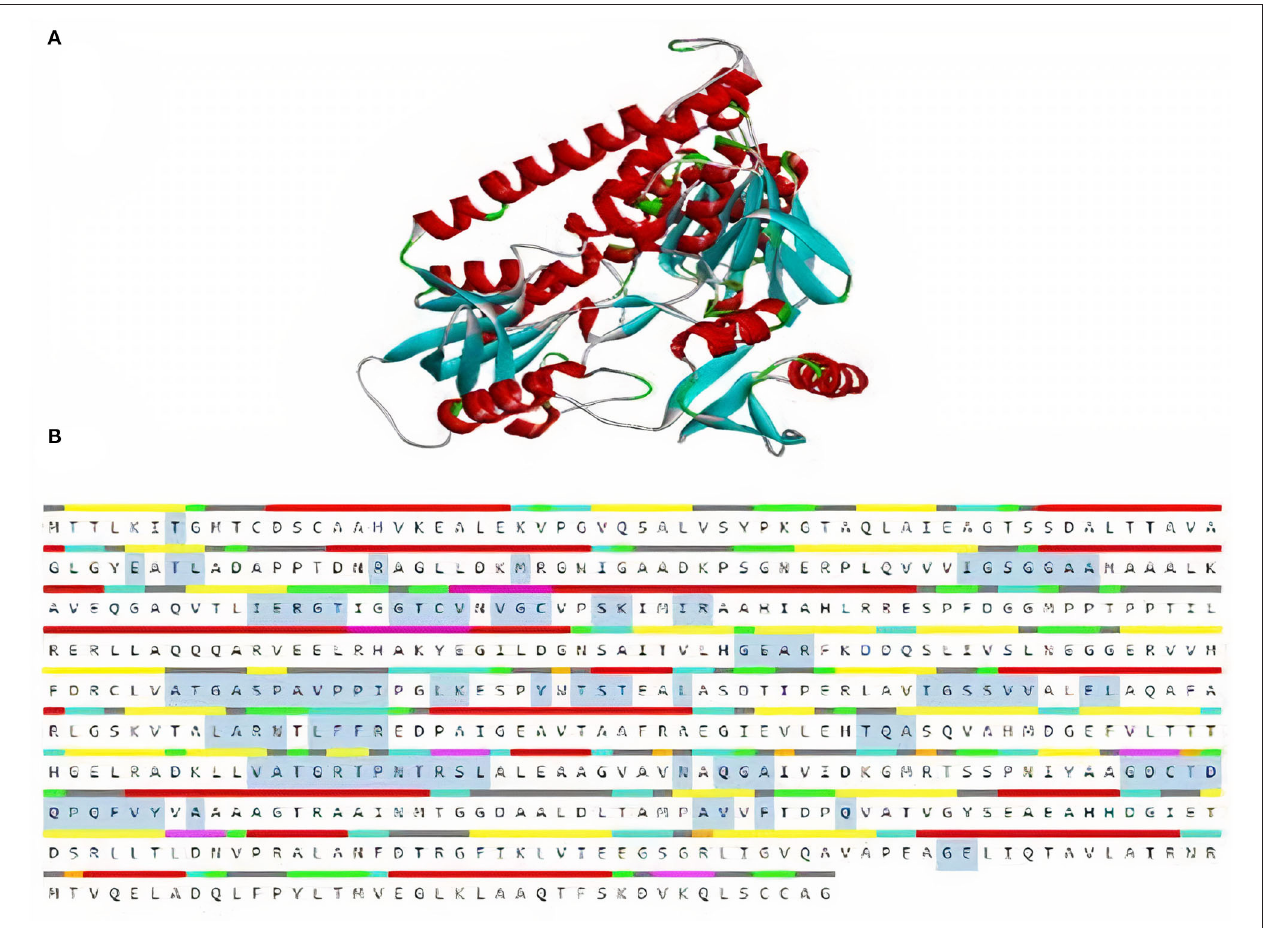
FIGURE 5 | (A) 3D model of MerA protein. (B) Representation of residues in binding pockets of MerA